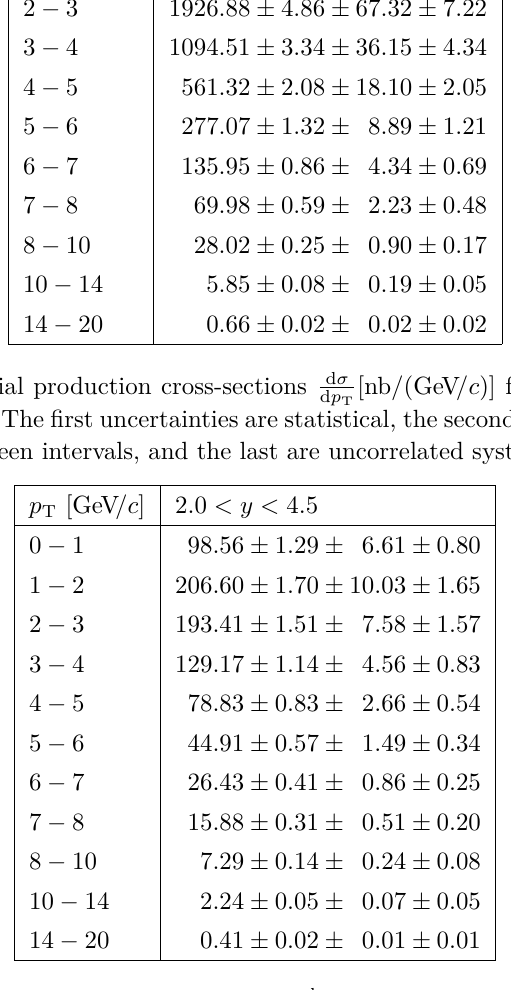
Table 6 . Single-differential production cross-sections d σ mesons. The first uncertainties are statistical, the second are correlated systematic uncertainties shared between intervals, and the last are uncorrelated systematic